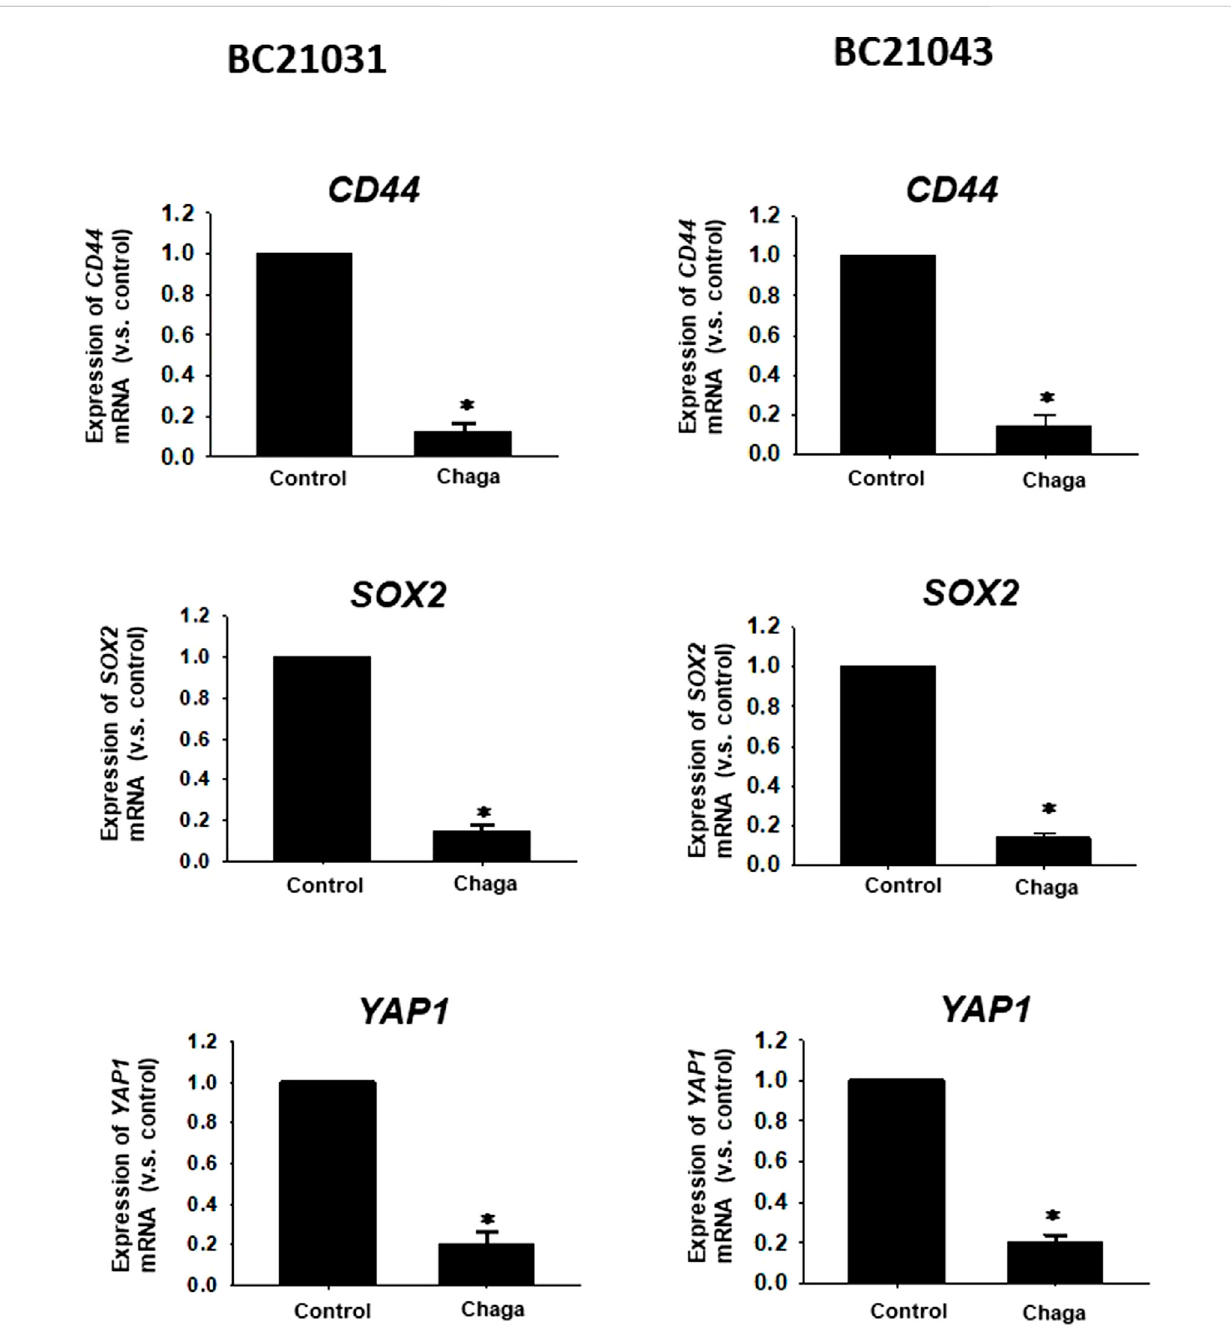
FIGURE 6 Effects of Chaga on stemness of DBCO. mRNA expression levels of CD44 , SOX2 , and YAP1 in Chaga-treated (100 μ g/ml for 24 h) DBCO were determined by quantitative real-time PCR. The expression level of each gene was quanti fi ed based on the ratio of expression level to GAPDH and shown as a fold increase relative to control (n = 4). Results were expressed as mean ± S.E.M. * p < 0.05 vs.